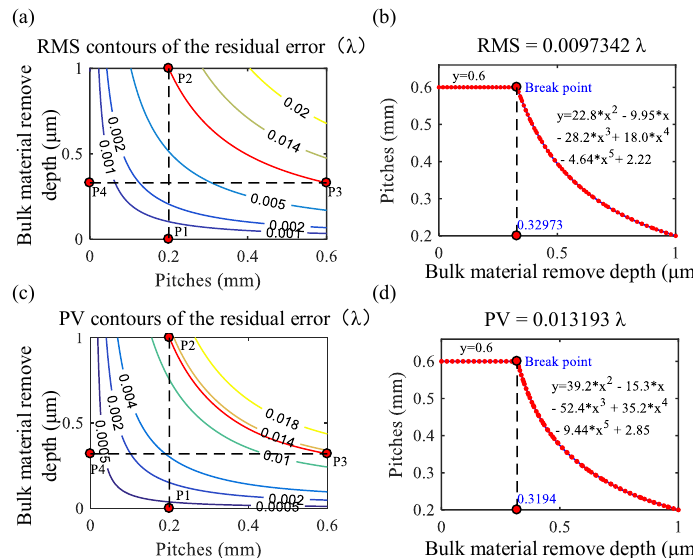
Figure 6. ( a ) RMS contours of the residual error; ( b ) relationship curve between bulk material removal depth and the path pitch based on the RMS map; ( c ) PV contours of the residual error; ( d ) relationship curve between bulk material removal depth and the path pitch based on the PV